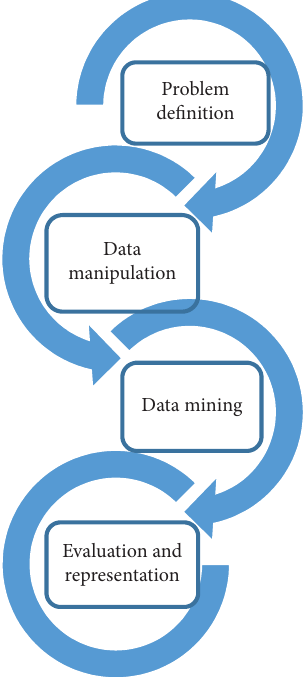
Figure 5: Stages of data mining